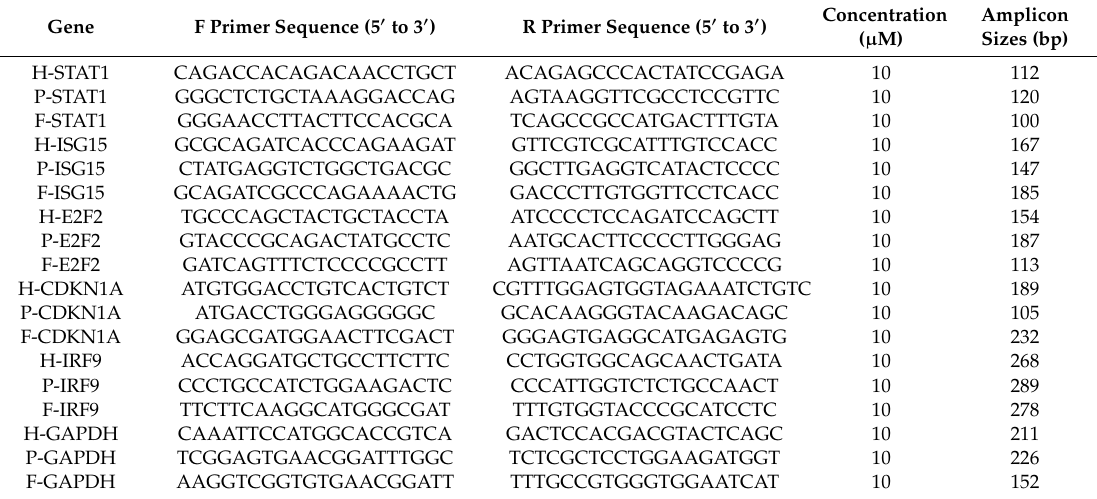
Table 2. The sequences of primers used for real-time